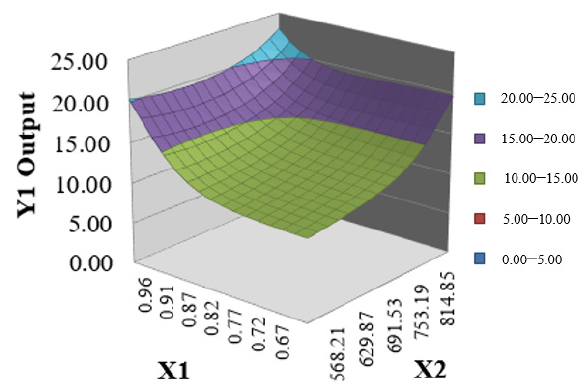
Figure 12. Three-dimensional (3D) modeling of relative compactness (X1), surface area (X2), and HL.